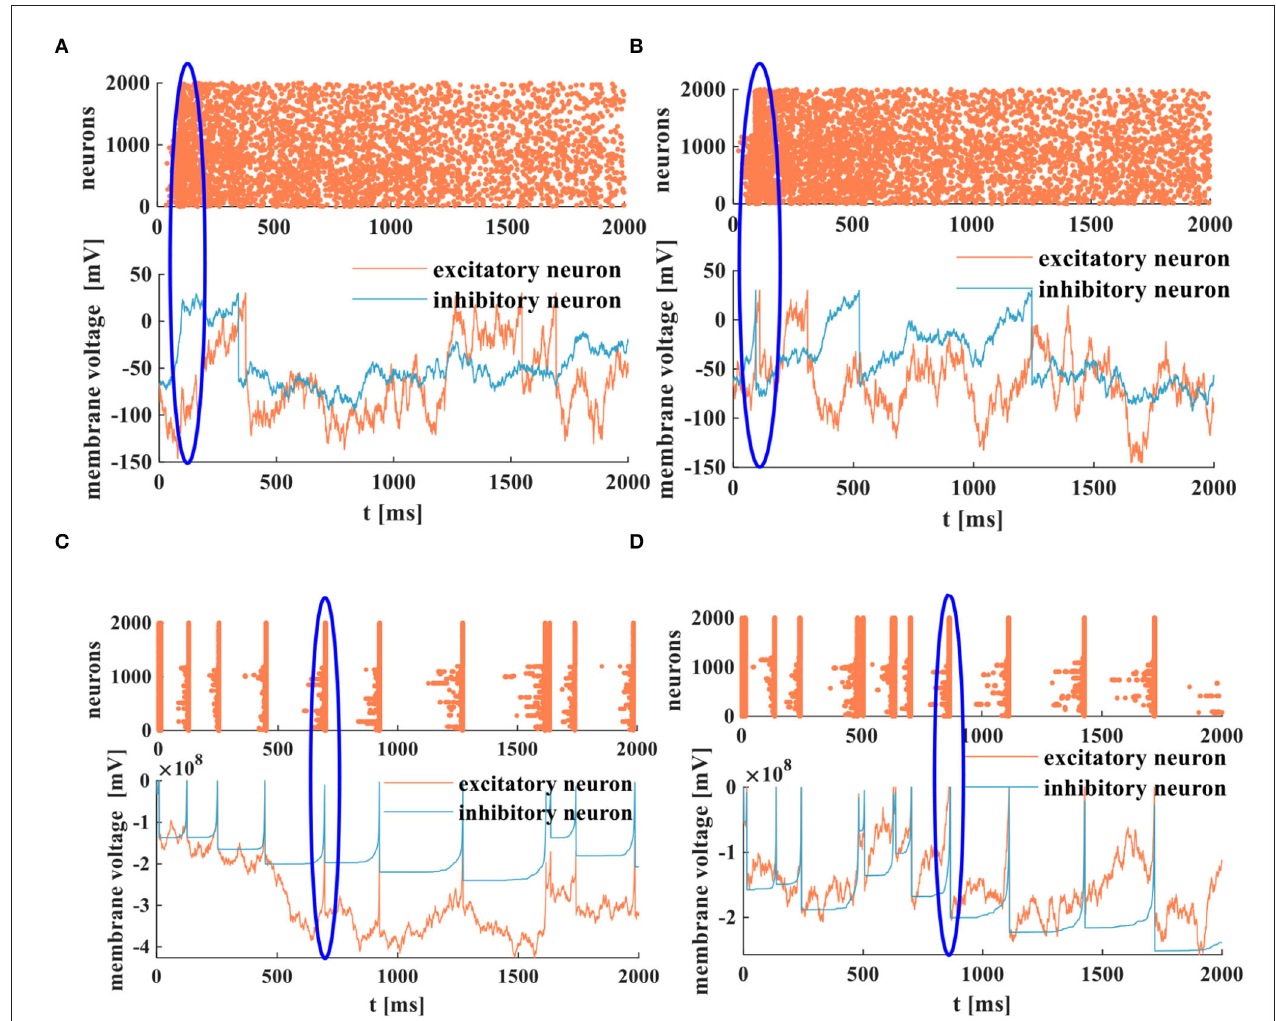
FIGURE 15 | The spike raster and the membrane potentials of the RC and the MC neuron models, (A) the asynchronous behaviors and the membrane potential of the RC neuron model, (B) the asynchronous behaviors and the membrane potential of the MC neuron model, (C) the synchronous behaviors and the membrane potential of the RC neuron model, (D) the synchronous behaviors and the membrane potential of the MC neuron